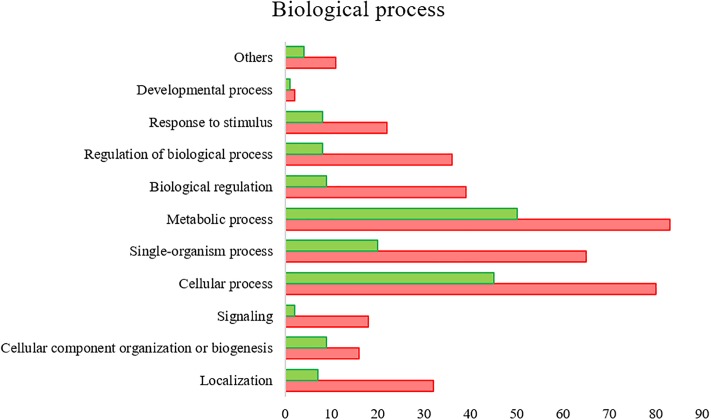
R. annulatus SGs transcriptional response to B. bigemina infection based on GO BP (level 2) of encoded proteins. Red bars represent down regulated genes, green bars represent up regulated genes with statistical significance (p < 0.05).